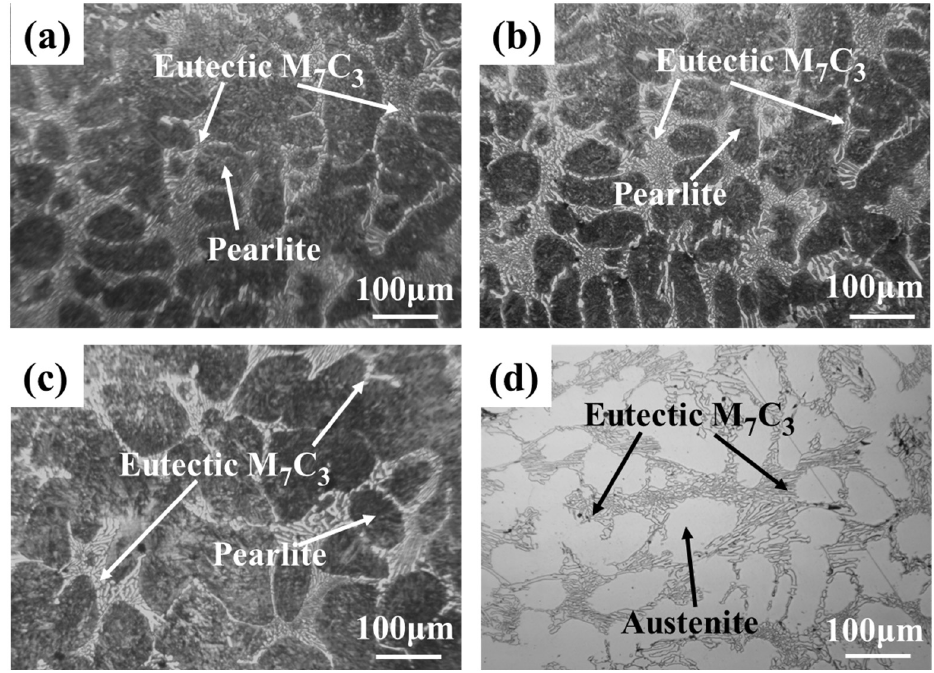
Figure 4. Optical images of the microstructure of the CICs: ( a ) CIC ‐ 1; ( b ) CIC ‐ 2; ( c ) CIC ‐ 3; ( d ) CIC ‐ 4.